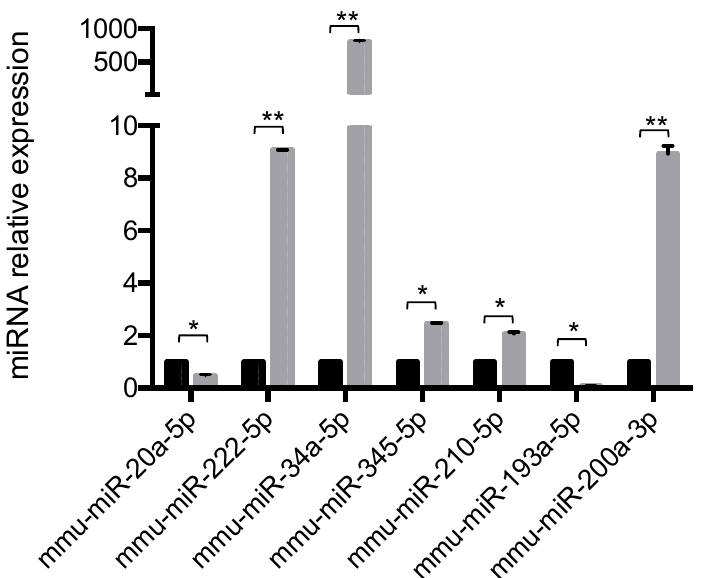
Figure 2. Quantitative PCR validation of mirnome in SHH MB CSC versus NSC. miRNA expression level of miRNAs (miR-20a-5p, miR-222-5p, miR-34a-5p, miR-345-5p, miR-210-5p, miR-193a-5p, and miR-200a-3p) in SHH MB CSCs vs. NSCs. Data are normalised versus endogenous control: U6. Results are shown in relative expression and data are means ± SD from three independent experiments. p -values * p < 0.05; ** p < 0.01.